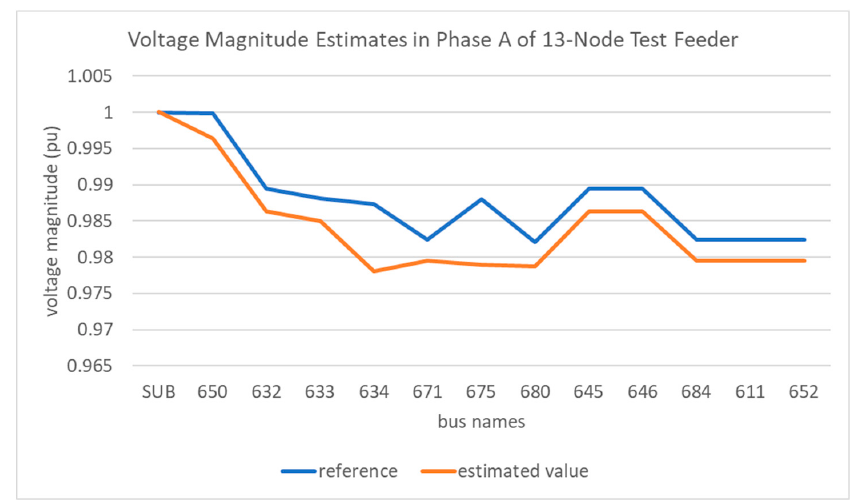
Figure 4. 13-bus feeder’s voltage magnitude estimates in phase A.